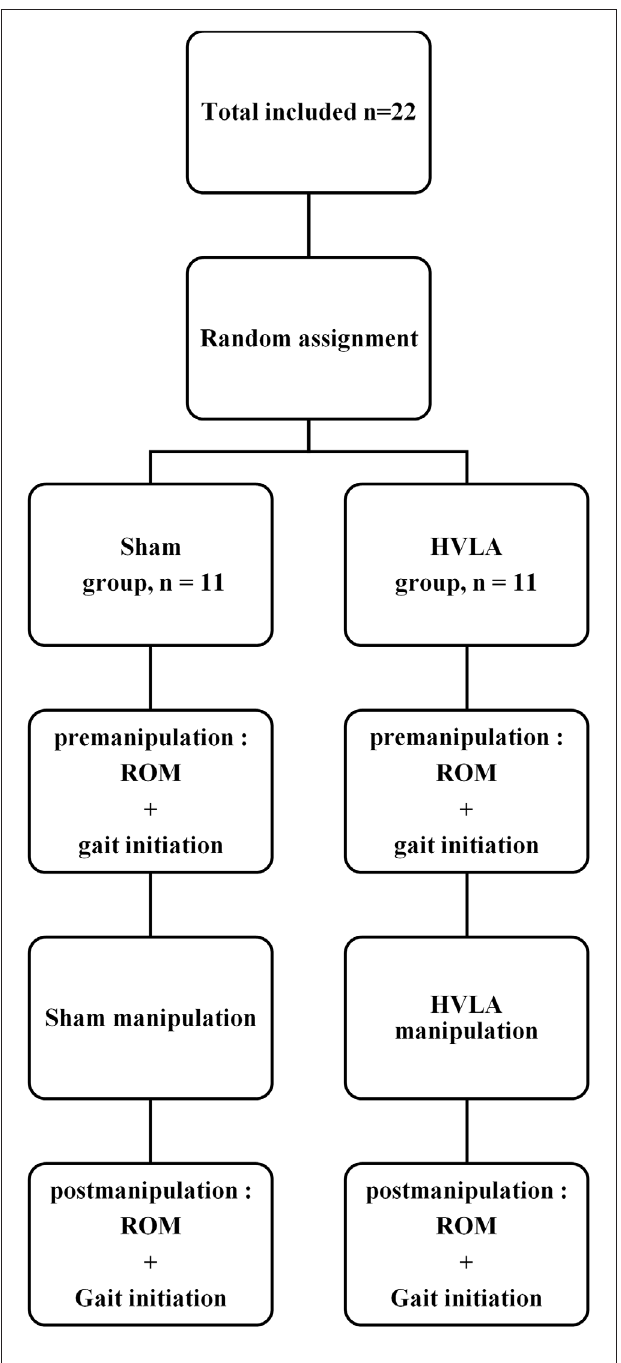
FIGURE 1 | Study flow